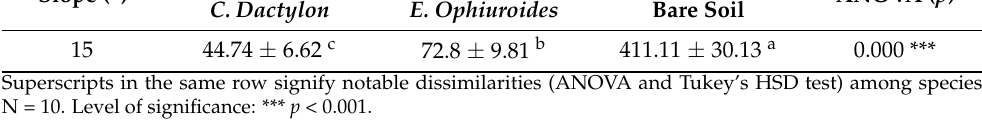
Table 5. Means ± SEs of soil loss amount for C. dactylon and E. ophiuroides and bare soil. Slope ( ◦ )